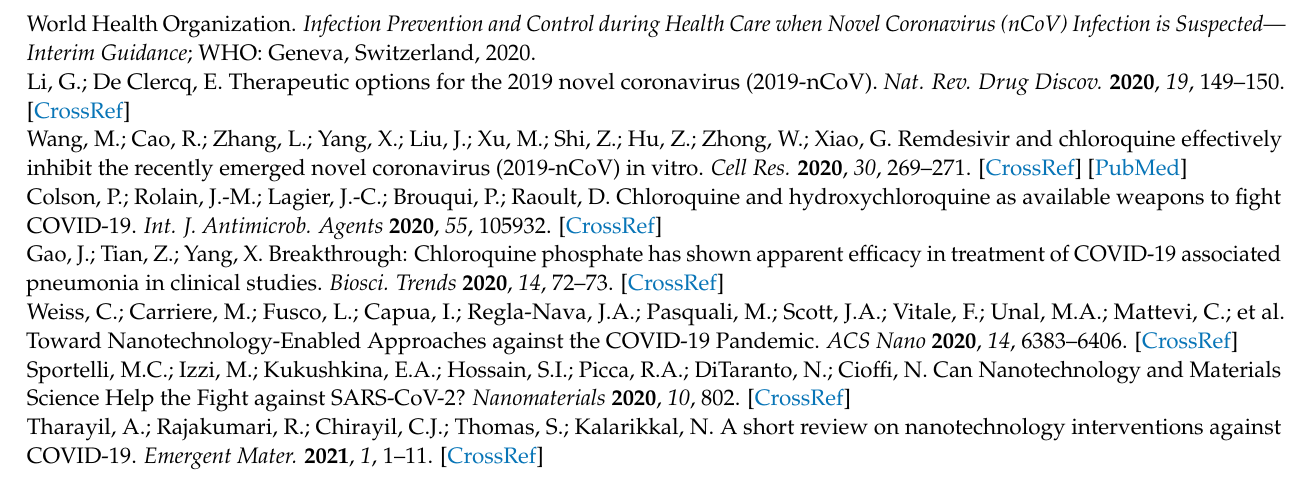
1/11/3/638/s1, Figure S1 Chemical composition from EDX analysis of the SiO 2 -Ag; Figure S2 (A) Relative concentration of RhB dye ( C n / C 0 ). (B) Reaction kinetics of the RhB degradation − ln( C n / C 0 ) versus time (min) for SiO 2 -Ag composite; Figure S3. Schematic representation of the different rings used for modeling SiO 2 . Silicon (yellow) and Oxygen (red); Figure S4. The optimized SiO 2 model used in the calculations; Table S1 Bond angles and lengths of the structure used; Figure S5. MEP (in eV) of SiO 2